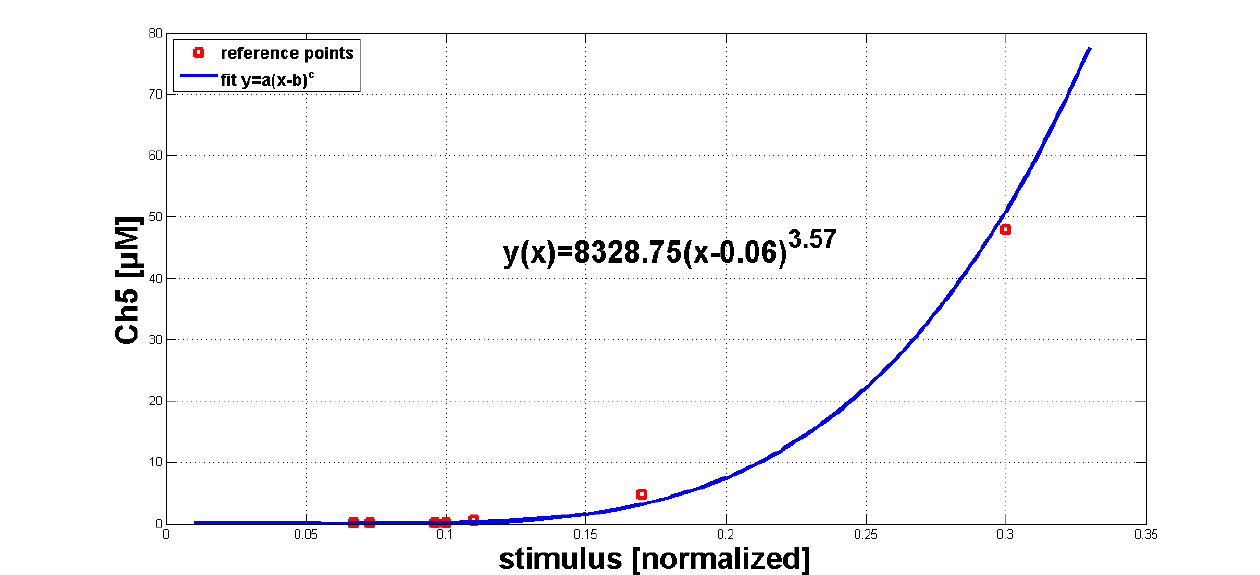
Figure A1. Transfer function that converts normalized values into Ch5